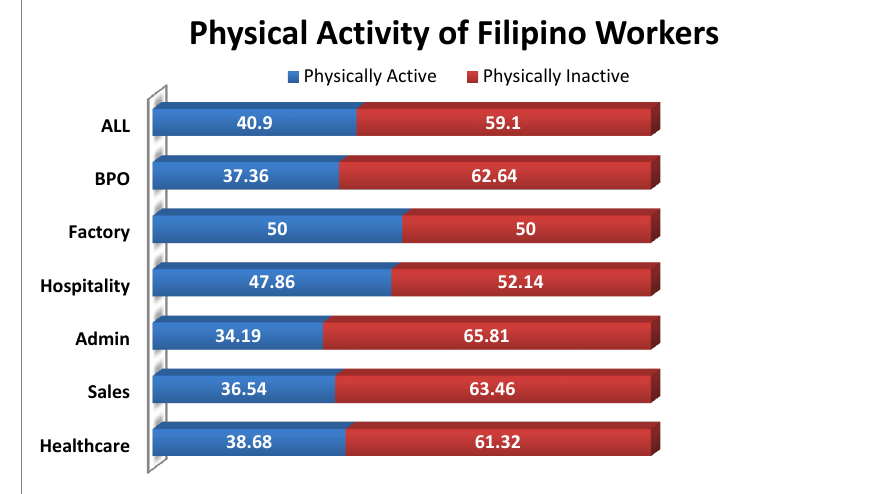
Figure 6. Percentage distribution of the respondents’ physical activity by sector.